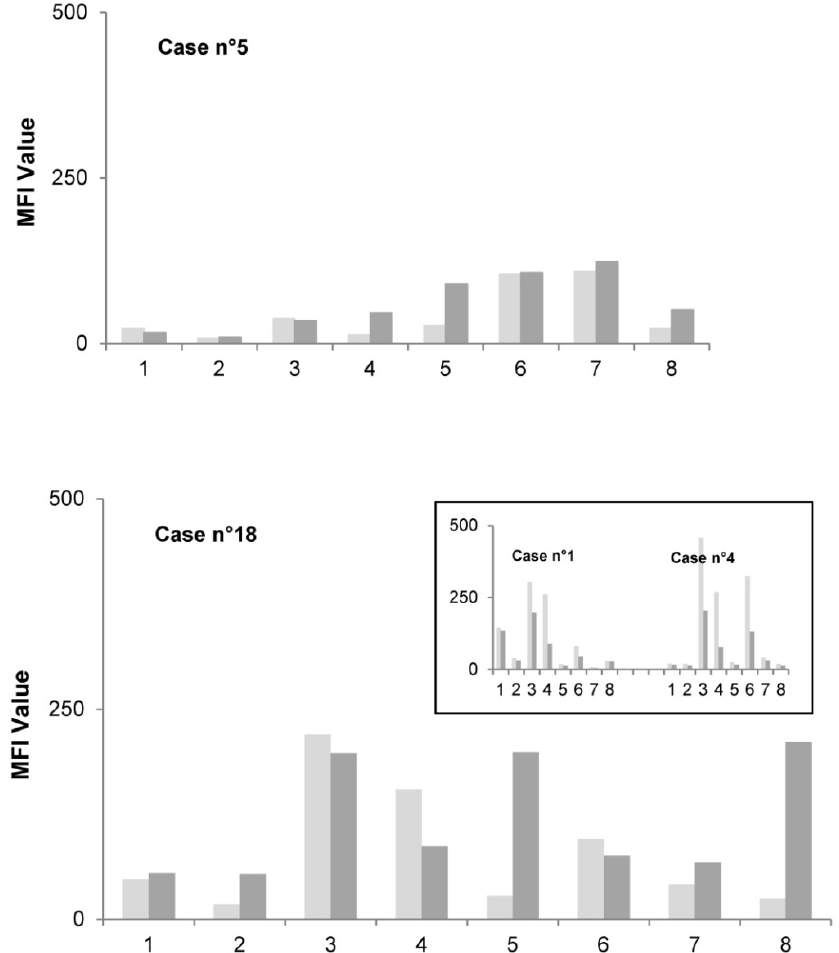
Figure 2. Response profiles of cases n°5 (A) and n°18 (B). The MFI values determined for each antigen (Ag) before surgery (T0, light gray) and one year post-surgery (T1, dark gray) are shown. Box: response profiles of S. lugdunensis cases °1 and n°4, note the lack of a response against antigens 5 and 8 in both